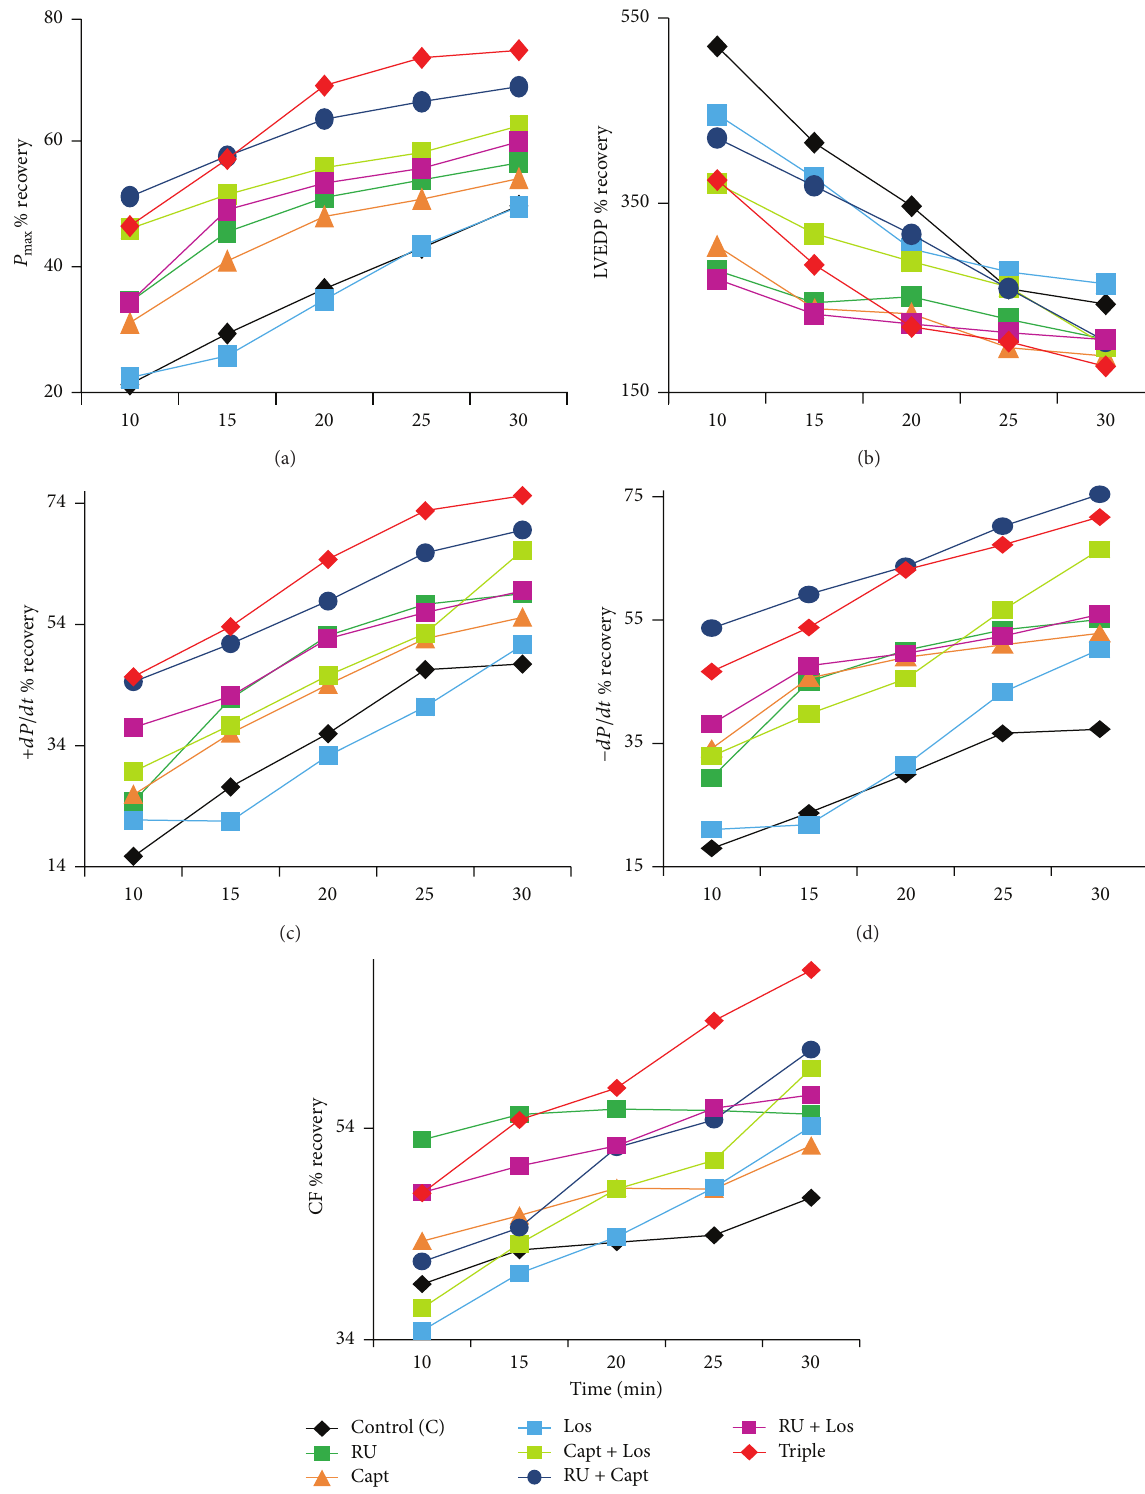
Figure 1: The effect of drugs given before ischemia on % recovery in cardiac function versus reperfusion time for (a) 𝑃 max , (b) LVEDP, (c) +𝑑𝑃/𝑑𝑡 , (d) −𝑑𝑃/𝑑𝑡 , and (e) CF in control hearts. RU: RU28318; Capt: Captopril; Los: Losartan; Triple: RU28318 + Captopril + Losartan; 𝑃 left ventricular developed pressure; LVEDP: left ventricular end-diastolic pressure; +𝑑𝑃/𝑑𝑡 : positive derivative of pressure; −𝑑𝑃/𝑑𝑡 : negative derivative of pressure; CF: Coronary flow; % 𝑅 : % recovery: (reperfusion/baseline) ×